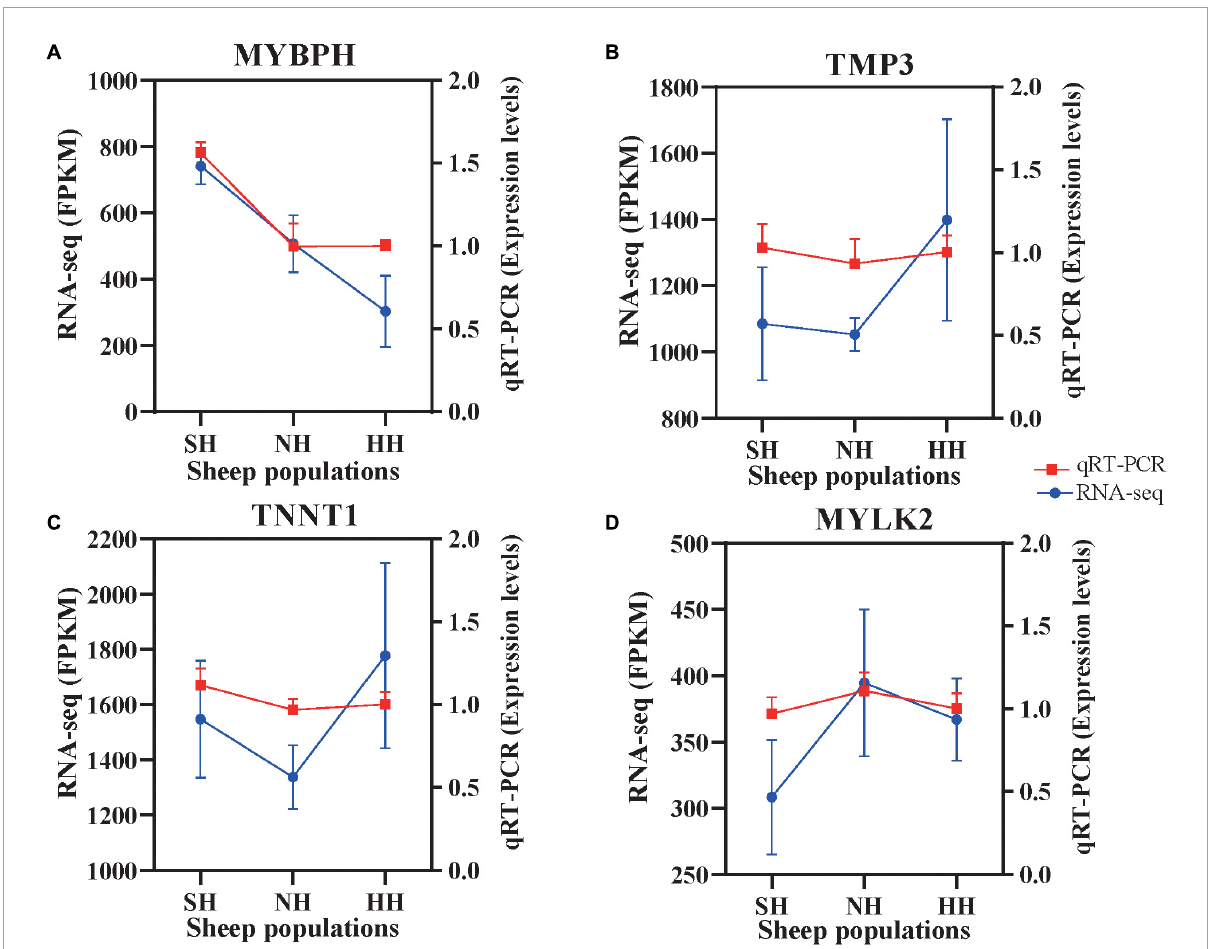
FIGURE8 Confirmation of expression patterns of the four selected genes via qRT-PCR. The qRT-PCR results were consistent with the RNA-seq data. (A) MYBPH; (B) TMP3; (C) TNNT1; (D) MYLK2.